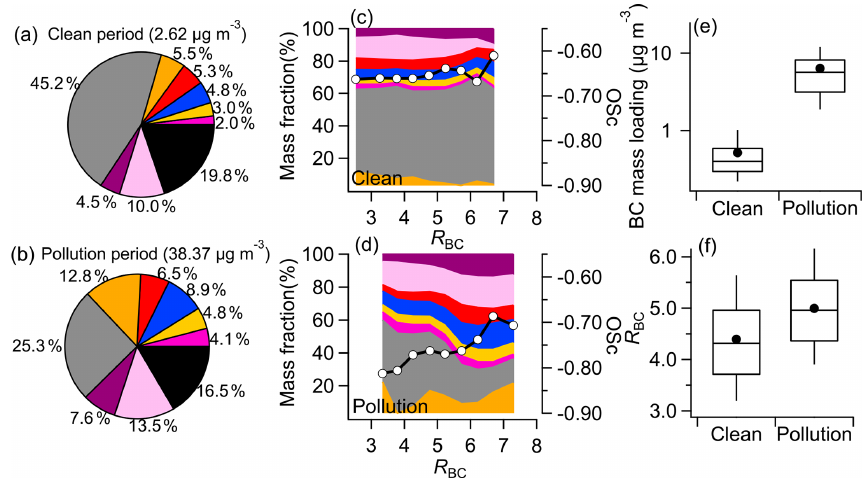
Figure 6. (a, b) Average compositions of BC-containing particles during clean and polluted periods, (c, d) mass fractions of the non-BC coating components (left y axis) and OS c (right y axis) during clean and polluted periods as a function of R BC , box plots of BC mass loadings (e) and R BC (f) during clean and polluted periods (colors of the components are consistent with those in Fig.